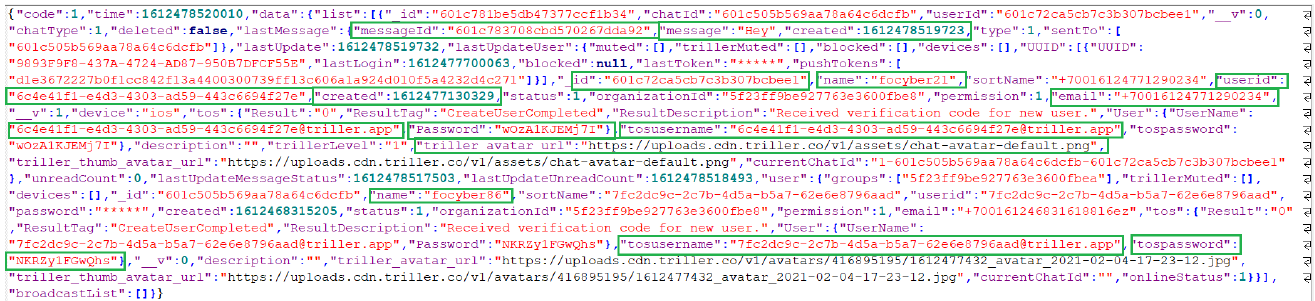
Figure 22. Draft chat message recovered from the iOS Triller